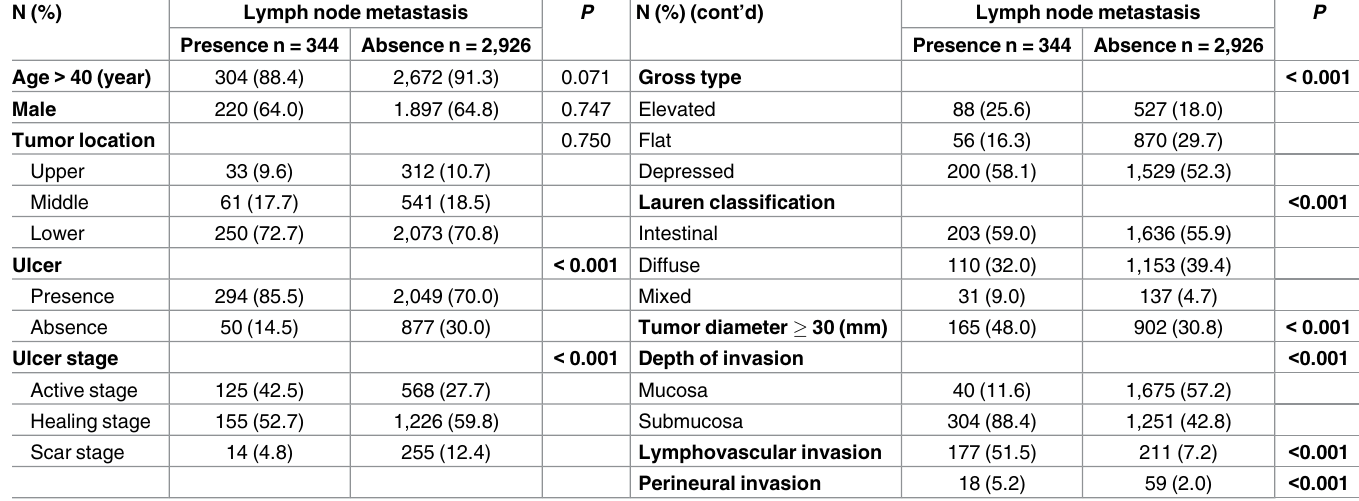
Table 4. Univariate Analysis of Risk Factors for Lymph Node Metastasis (n = 3,270). N